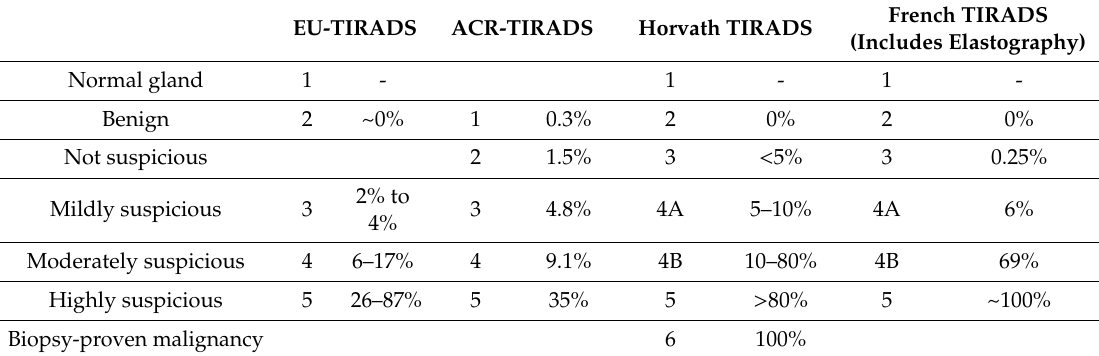
Table 2. Comparative US Classification of Nodules: Categories for each scoring system with the expected malignancy risk for each category.